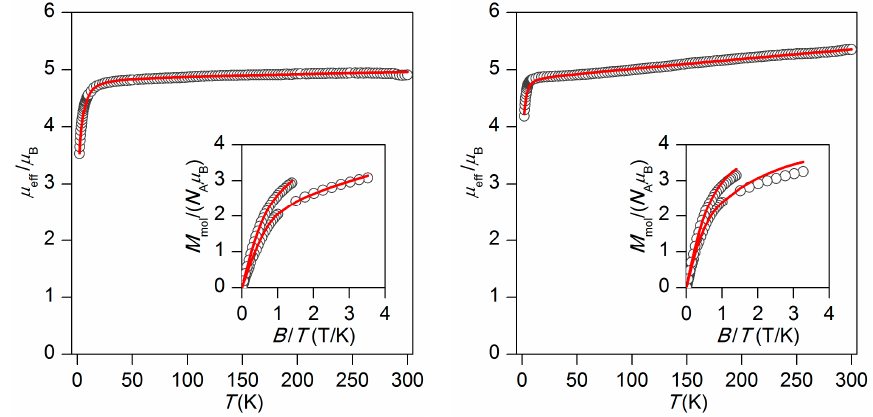
Figure 3. The magnetic data for 2a ( left ) and 2b ( right ) showing the temperature dependence of the effective magnetic moment calculated from the molar magnetization measured at B = 0.1 T, and the reduced isothermal magnetizations measured at T = 2 and 5 K. Empty circles—experimental data, full lines—calculated data, using Equation (1), and D = − 3.7(1) cm − 1 , g = 1.981(6), zj = − 0.244(9) cm − 1 , χ TIM = 6(1)·10 − 9 m 3 ·mol − 1 for 2a and D = − 2.2(1) cm − 1 , g = 1.975(8), zj = − 0.02(1) cm − 1 , χ TIM = 28(2) 10 − 9 m 3 ·mol − 1 for 2b .